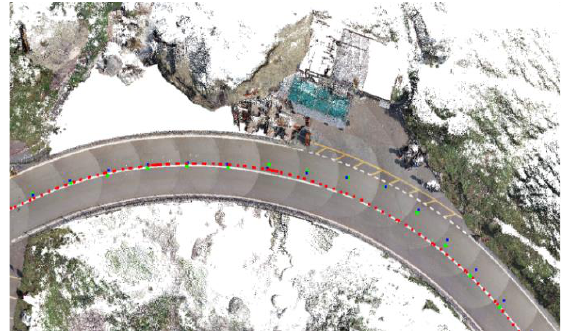
Figure 15. Comparison between the polylines of the ground truth, the alignment and the trajectory close to a car lay-by. Ground truth in red, alignment in green and trajectory in blue. Last, Figure 16 shows a visual representation of the atomically generated IFC model, which contains alignment and roadway width information.